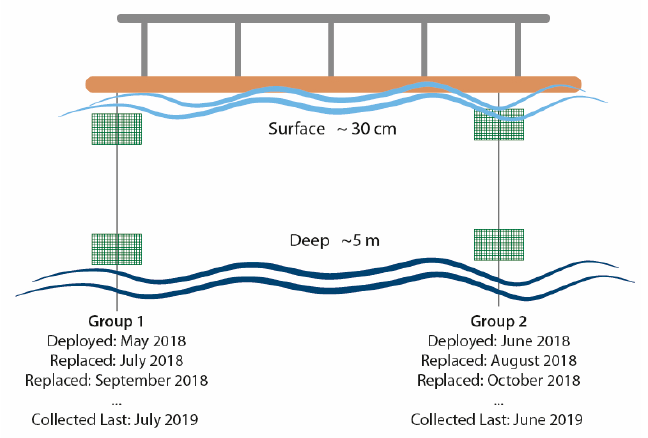
Figure 2. Graphic representation of the sampling scheme depicting the sampling depths and the collection